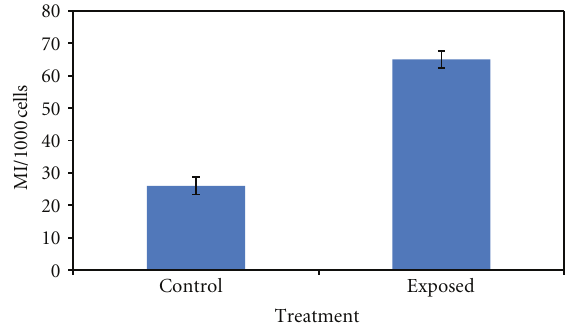
Figure 6: Mitotic index in bone marrow cells of control newborn rats and those exposed to 50Hz and 0.5 mT MF for 30 days 24 h/day. Mean ± S.E. ( P < 0 .